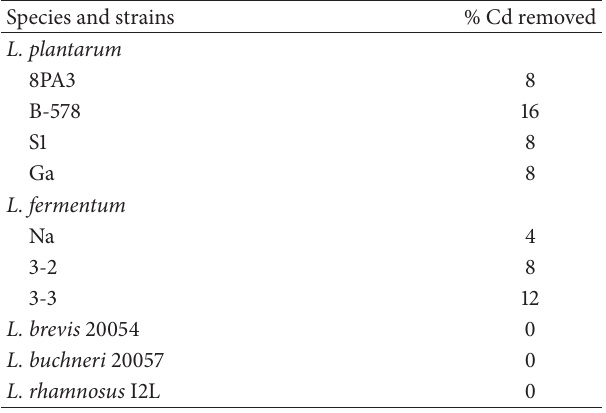
Table 2: Removal of Cd from MRS broth by Lactobacillus strains. Species and strains % Cd